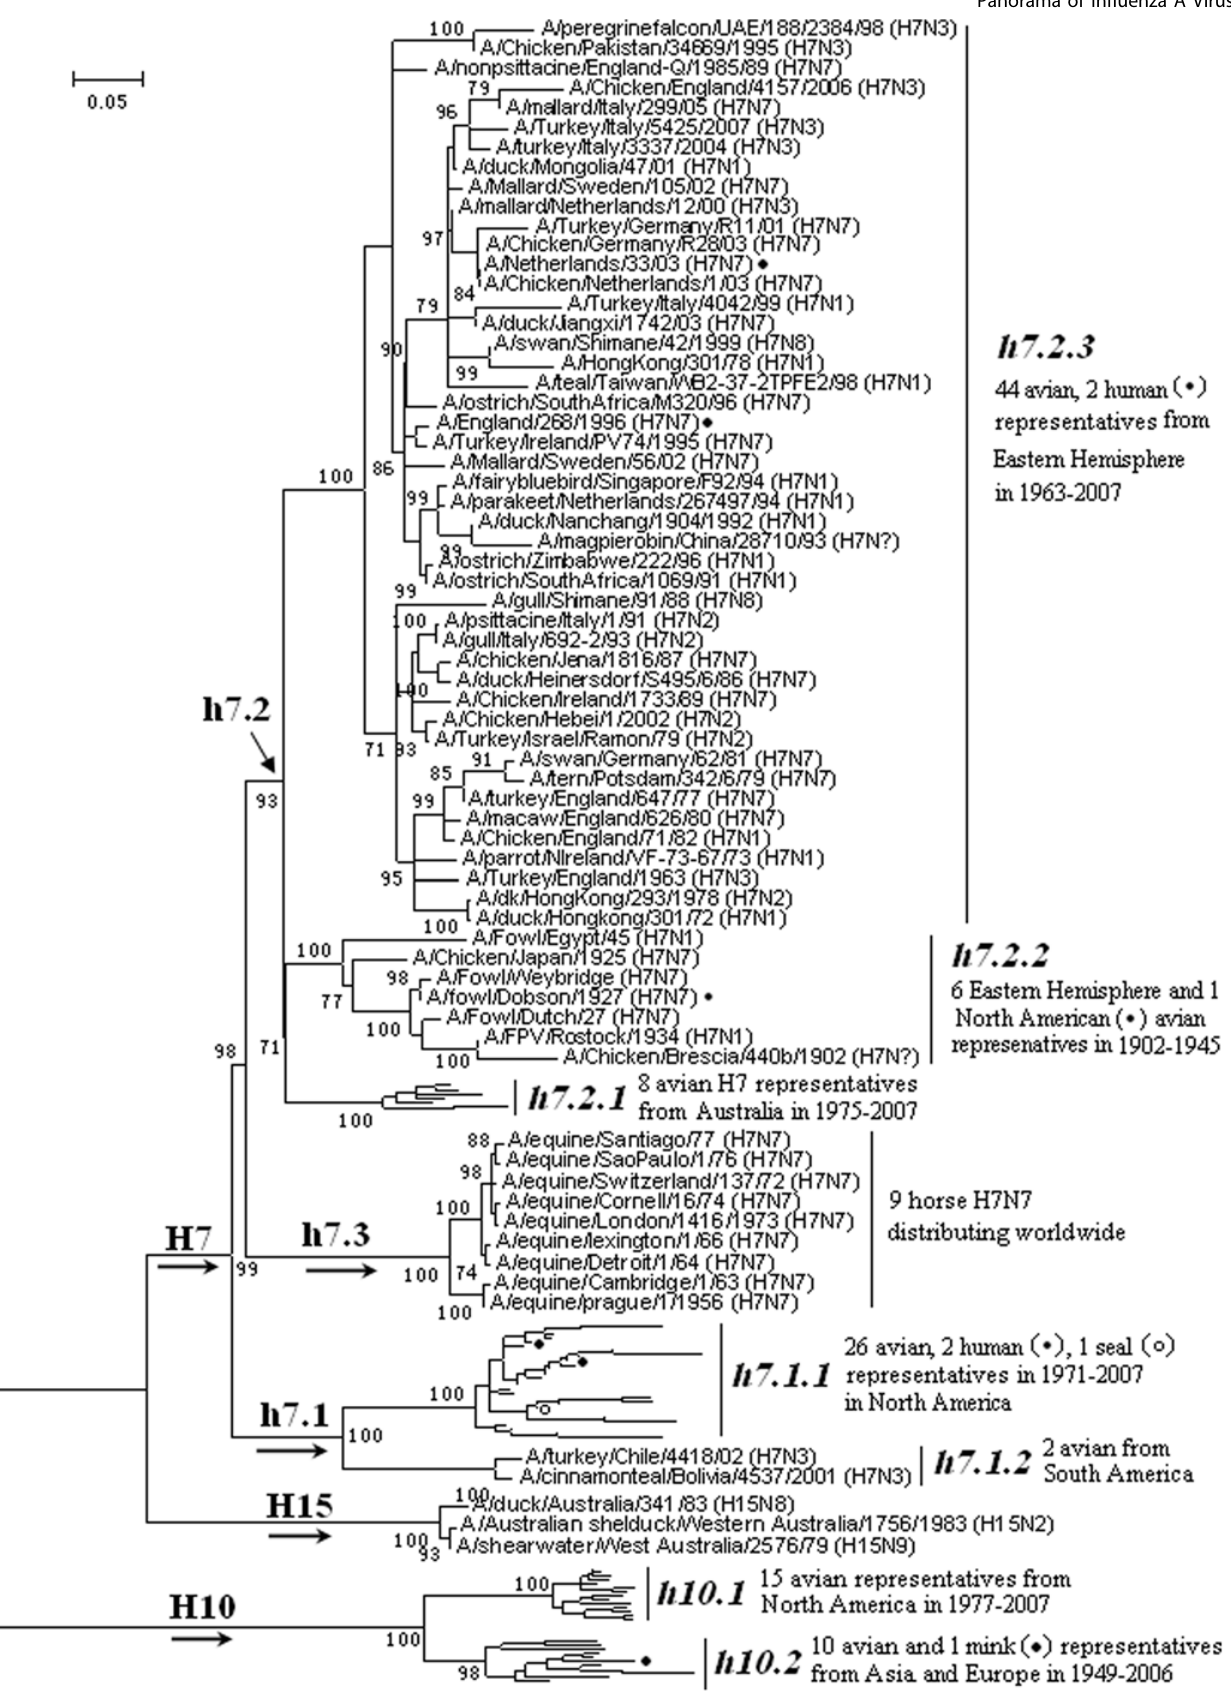
Figure 7. The panorama phylogenetic tree of subtypes H7, H10 and H15 influenza virus based on the viral HA sequences. Bootstrap values were given at relevant nodes. doi:10.1371/journal.pone.0005022.g007 PLoS ONE |